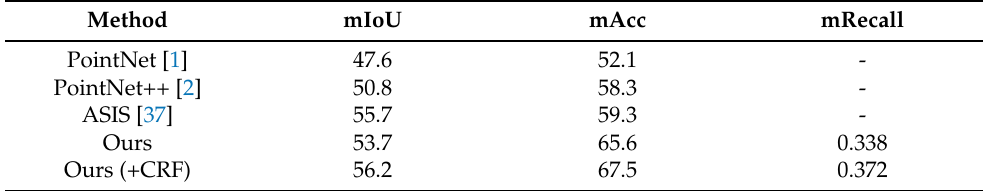
Table 2. Semantic segmentation mIoU, oAcc and mRecall on S3DIS.(a) is accuracy results of seman- tic segmentation. (b)is IoU results of semantic segmentation, (c) is precision results of semantic segmentation, (d) is recall results of semantic